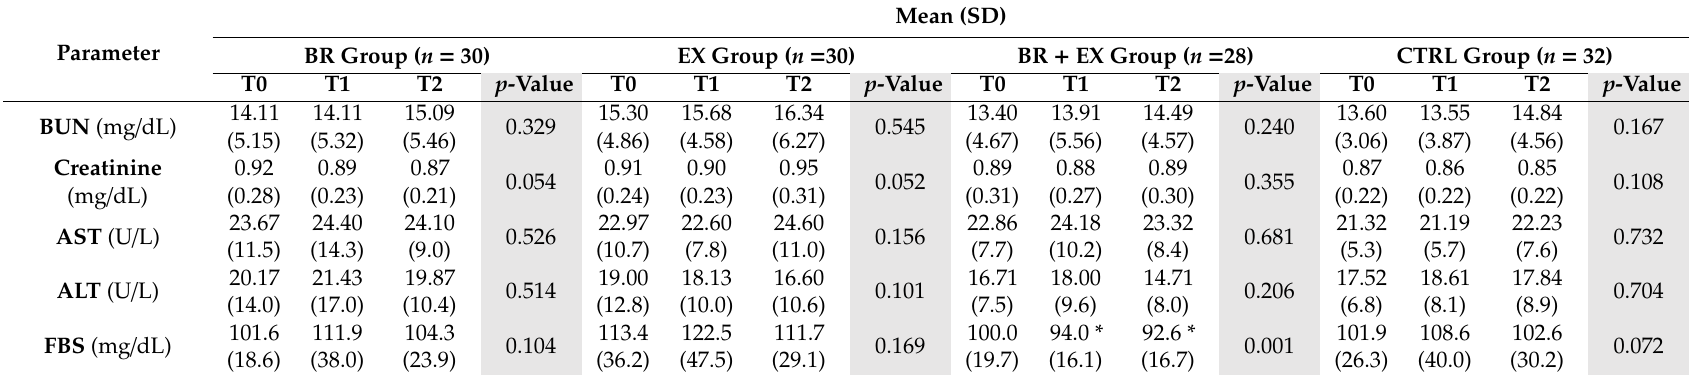
Table 3. Changes in general blood-based health profile parameters (kidney function, liver enzymes, and fasting blood sugar) in all 4 di ff erent intervention groups during the 24-week intervention